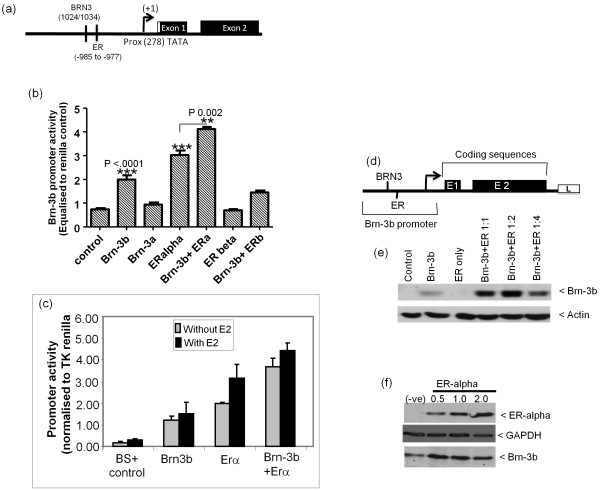
Cooperation between Brn-3b and ER can stimulate promoter activity. (a) Schematic diagram showing position of Brn-3 consensus binding sites and oestrogen response element (ERE) site relative to the proximal -278TATA, (now designated +1). (b) Promoter activity following cotransfection of the BSX reporter construct with Brn-3b, Brn-3a, ERα or ERβ alone or in different combinations into MCF-7 cells. Values have been equalised with internal Renilla control [renilla reporter gene driven by minimal tyrosine kinase (TK) promoter] and represent means ± SD of three independent experiments. (c) Brn-3b promoter activity when coexpressed with Brn-3b and ERα, alone or together, in cells grown in oestrogen-depleted medium and either untreated or treated with estradiol, after transfection. Grey bars show inducibility in the absence of estradiol, and black bars demonstrate the effects of adding estradiol after transfection with the constructs described. (d) Schematic showing the modified expression construct, BSXE1E, in which the Brn-3b promoter drives expression of the Brn-3b gene upstream of luciferase reporter (L). (e) Immunoblot showing changes in Brn-3b protein produced from the BSXE1E expression construct when cotransfected with Brn-3b or ERα alone or in combination (at different ratios of Brn-3b:ER, 1:1 to 1:4). Actin immunoblot was used to indicate variation in protein loading. To demonstrate that Brn-3b protein levels was dependent on the ratio of Brn-3b to ER, shorter exposure times and therefore smaller increases in Brn-3b expression are not evident when ER only is expressed. (f) Immunoblot to show increases in ER protein following transfection with expression constructs (top immunoblot) and a corresponding changes in endogenous Brn-3b protein that were dependent on concentrations of ERα (middle immunoblot). GAPDH immunoblot is included to show variation in protein loading.